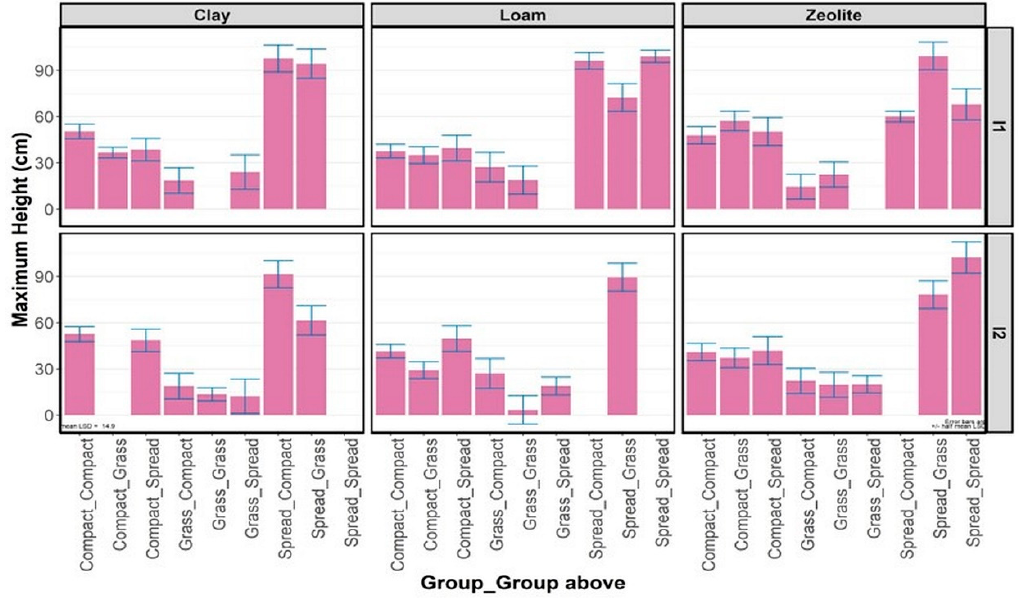
Figure 5. Carry-over predictions of H max for plant groups in di ff erent substrates and irrigation treatments. Error bars are approximately ± 0.5 LSD (5%); if they do not overlap, the predicted means are significantly di ff erent ( p ≤ 0.05), while those whose error bars overlap are not significantly di ff erent ( p > 0.05).